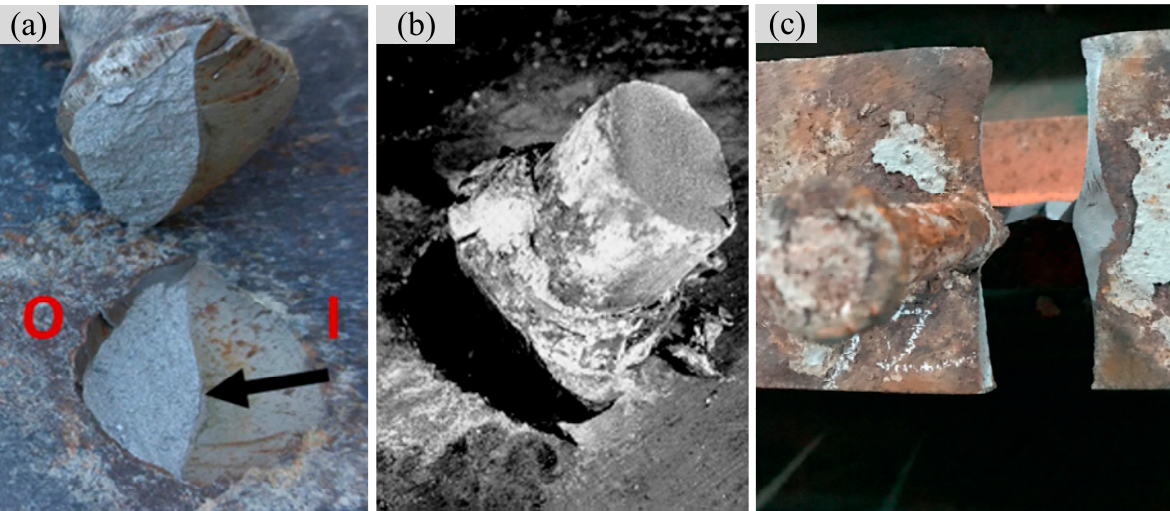
Figure 1. Failure modes of headed shear studs: ( a ) in the root of the stud [3]; ( b ) in the root of the weld collar [18]; ( c ) from the root of weld collar and propagated to the flange [19].